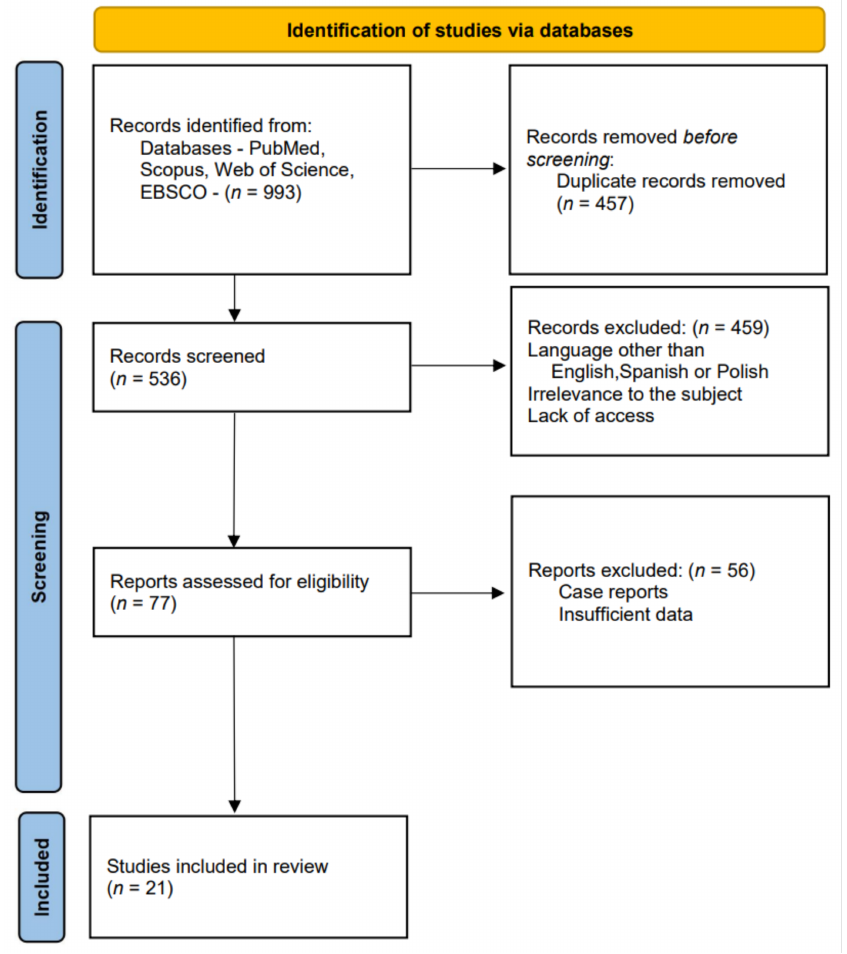
Figure 2. Studies’